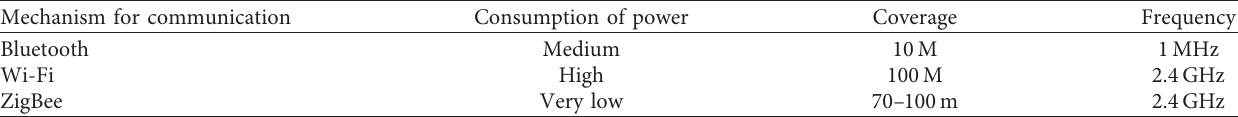
Table 2: Summarization of the mechanism for